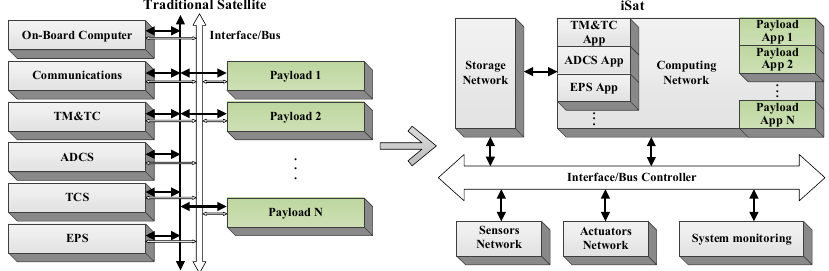
Figure 2. The hardware structure of the traditional satellite and iSat.